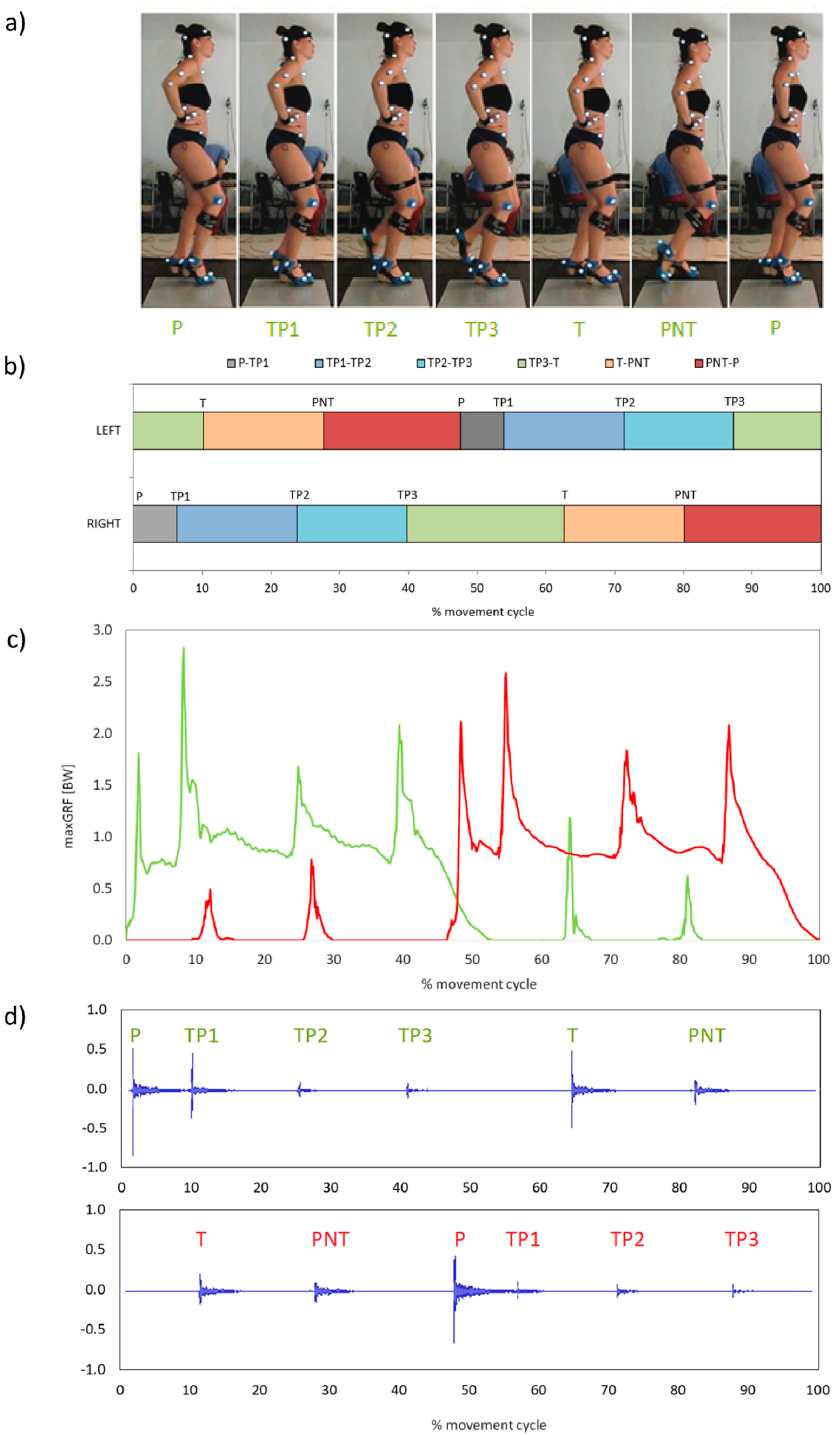
Figure 1. ZAP-3 cycle in flamenco: ( a ) body position; ( b ) averaged duration between successive strikes; ( c ) exampled course of the vertical component of ground reaction force (GRF); ( d ) example waveform view of the sound of footwork strikes.